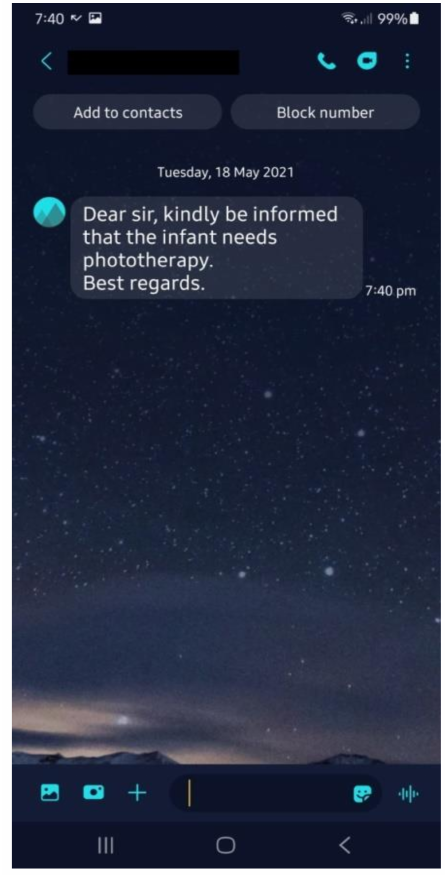
Figure 8. An example of the SMS sent by the proposed system to the care